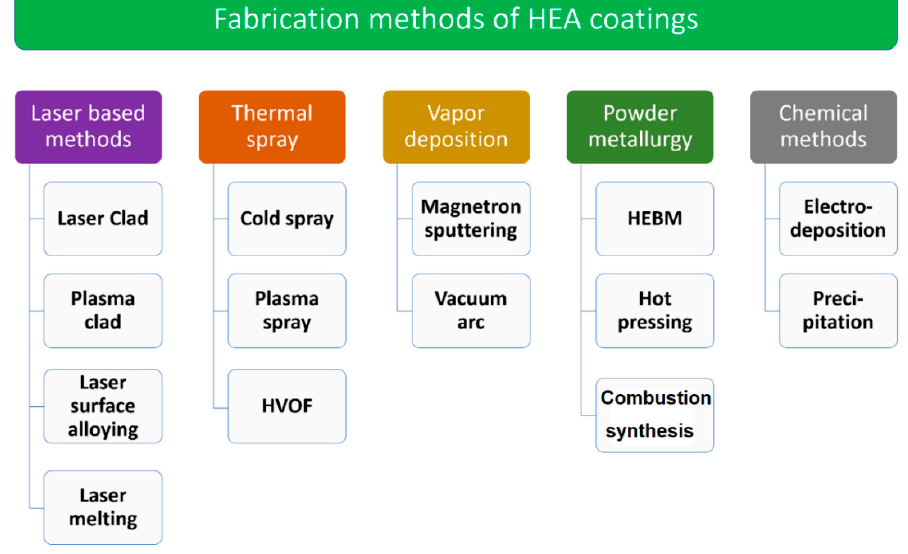
Figure 3. Methods of fabricating various HEA coatings.